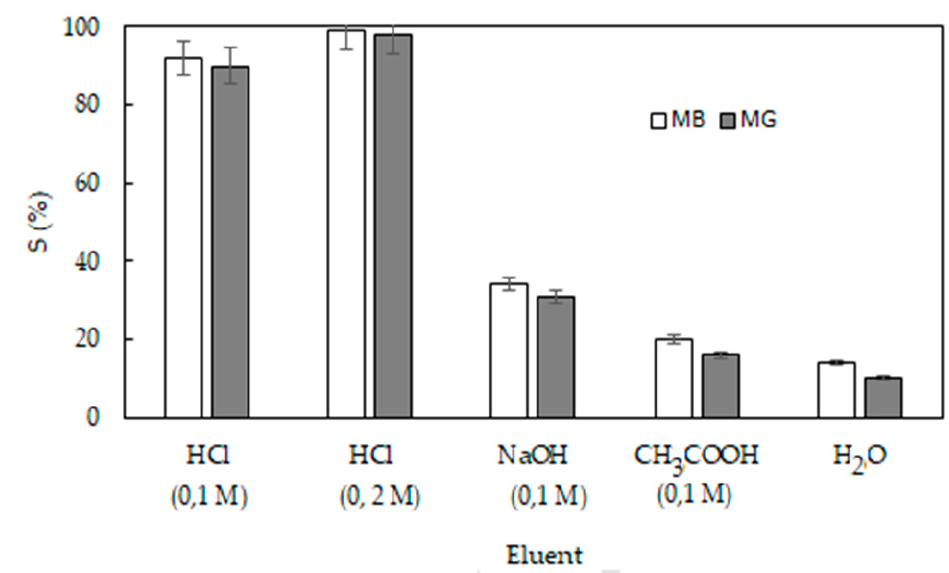
Figure 4. Desorption of the cationic dyes from dye-loaded CS-C by different eluents. As seen from Figure 4, HCl solutions were the most efficient eluents to desorb the cationic dyes from the dye-loaded CS-C (Figure 4). It was observed that desorption percentages for methylene blue and malachite green by the HCl solution (0.1 M) were 92% and 90% and by the HCl solution (0.2 M) were 99% and 98%, respectively. The NaOH solution can withdraw 34% methylene blue and 31% malachite green, respectively.